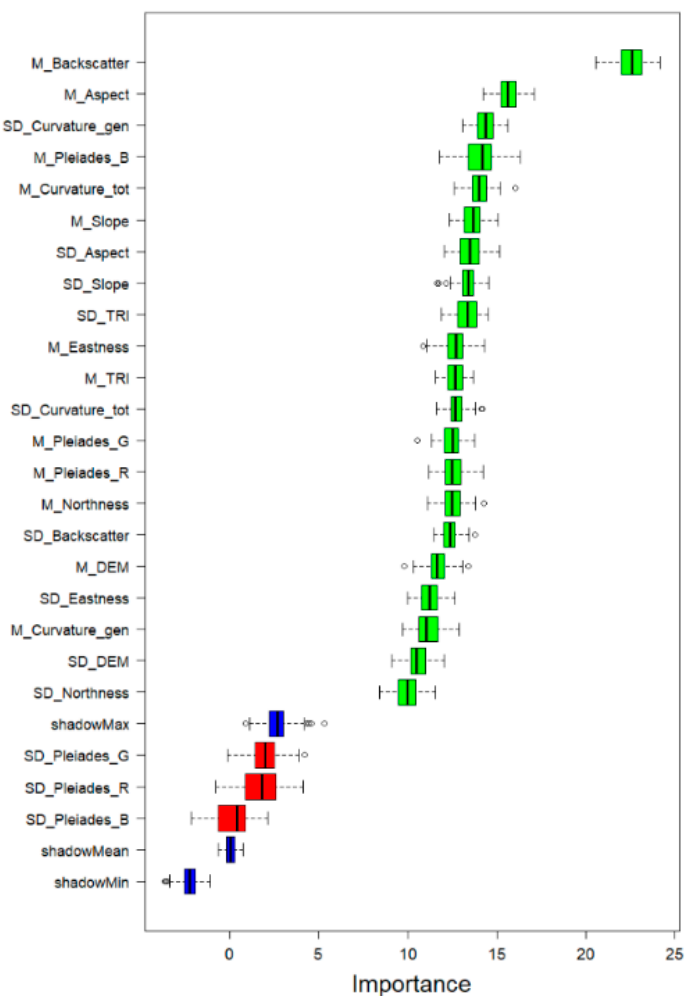
Figure 12. Results of the Boruta feature selection algorithm. Blue boxplots correspond to minimal, average and maximum Z score of a shadow attribute. M: mean; SD: standard deviation.